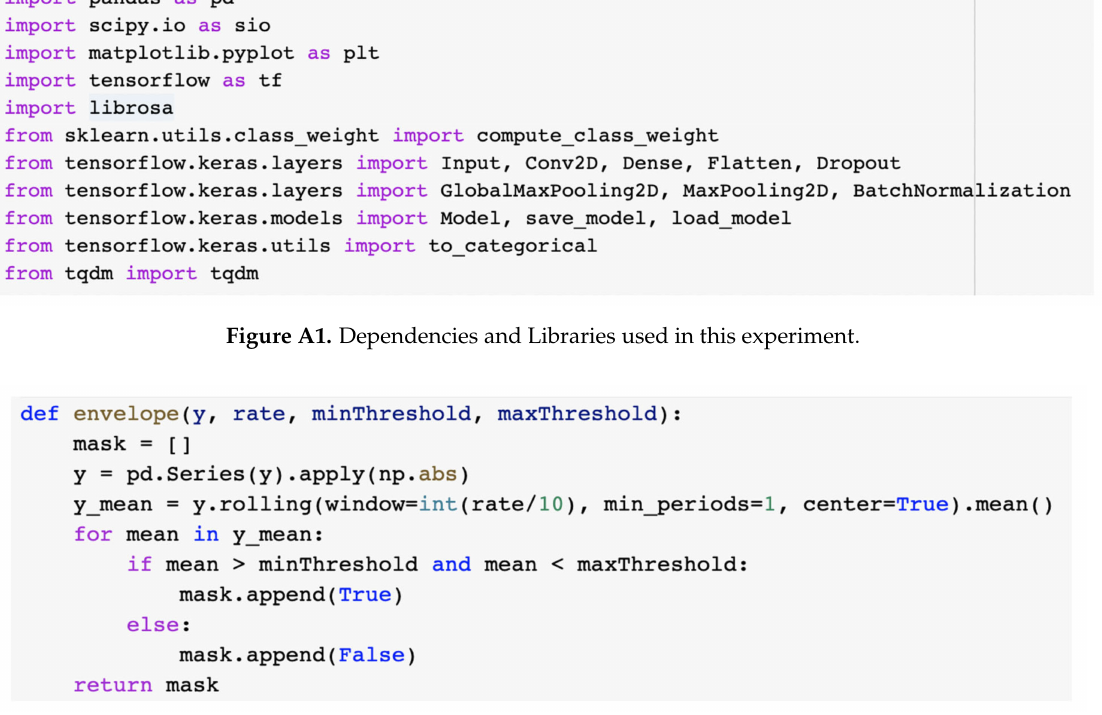
Figure A2. Envelope Function